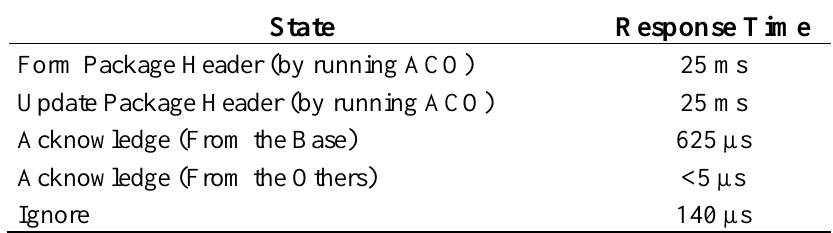
Table 3. Response times of the router